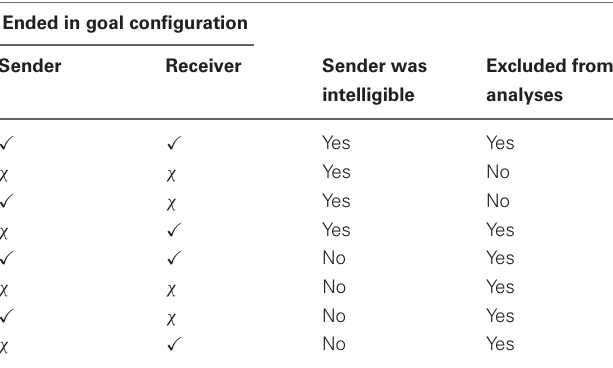
Table A1 | Overview of which types of trials t − 2 were excluded from the analyses, based on our definition of intelligible